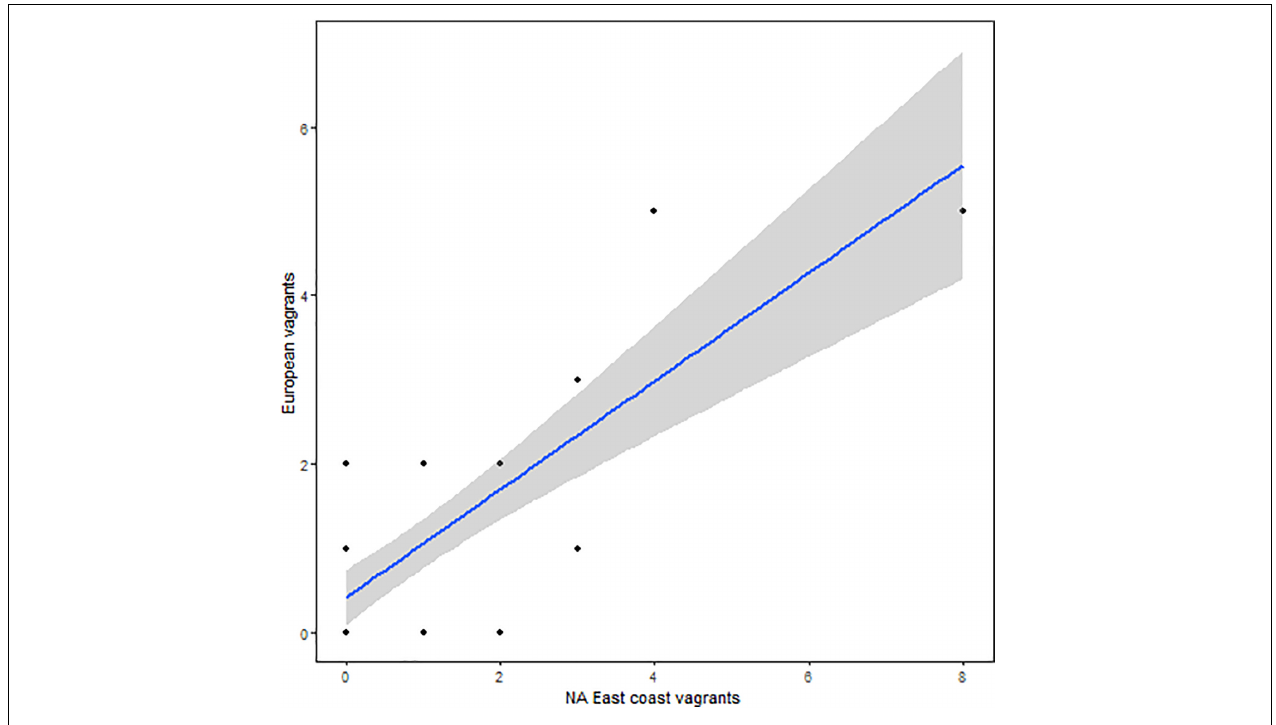
FIGURE 10 | Relation between numbers of vagrant elegant terns on the east coast of North America and vagrants to Europe.